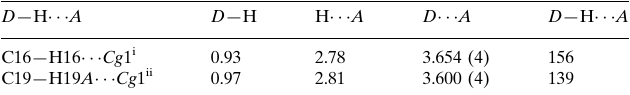
Hydrogen-bond geometry (A˚ , (cid:1)